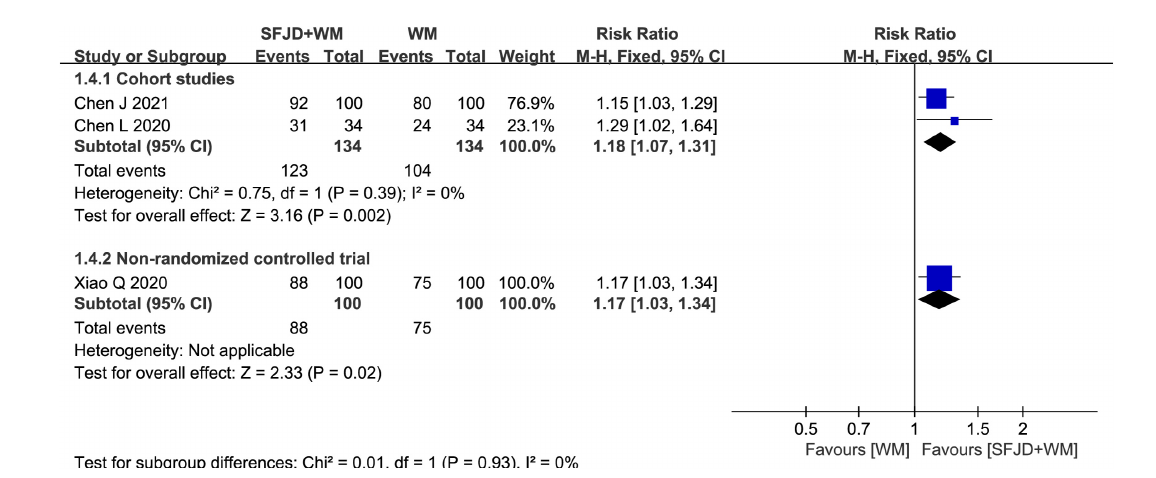
FIGURE4 Meta-analysis of total effective rate in the SFJD + WM group vs. the WM group in COVID-19 patients.